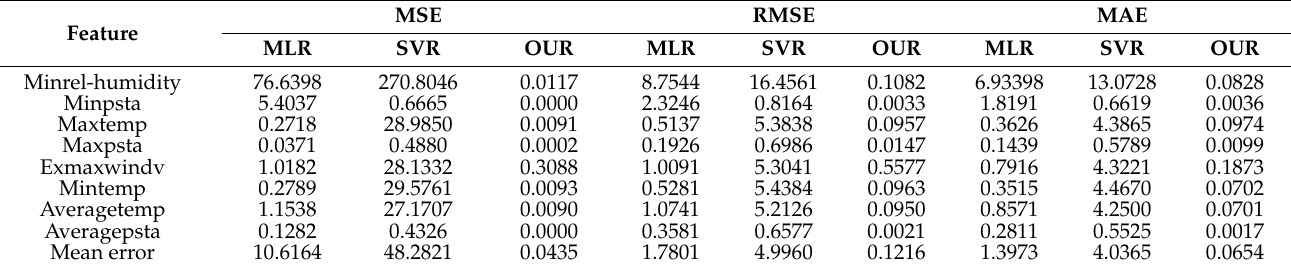
Table 5. Error comparison results of regression models (a).